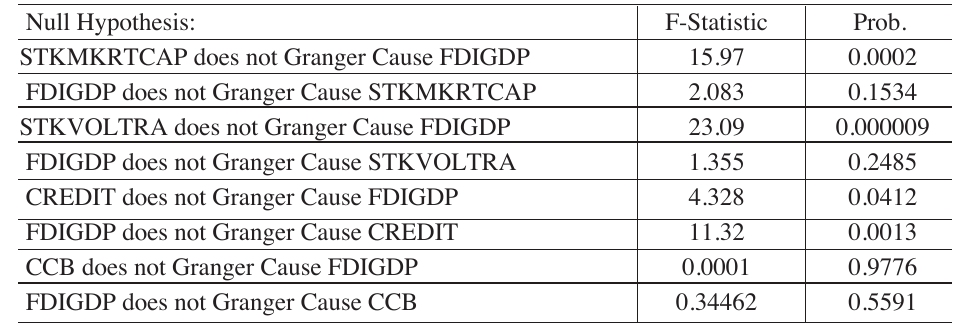
Causality test between FDI and